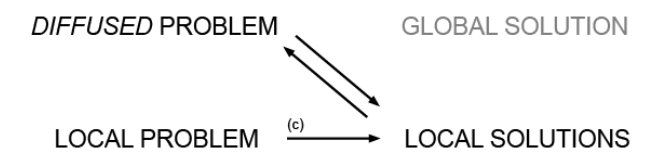
Figure 3 . Path used in the present case study: from local problem to local solution. Through “global” discussions and re-appropriation cycles there is a chance to disseminate several local